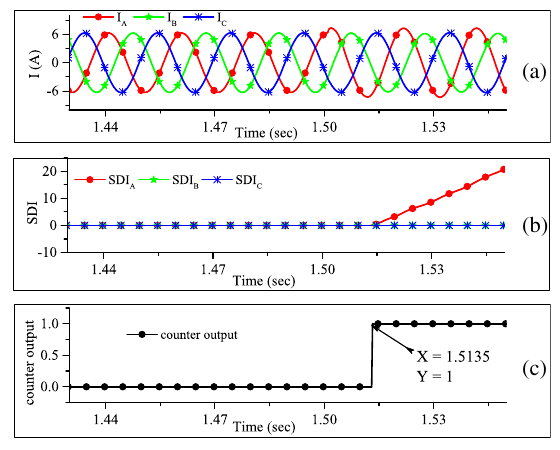
Fig. 5 Ag fault occurred at far-end: ( a ) Current waveforms, ( b ) SDI trajectories ( c ) Counter